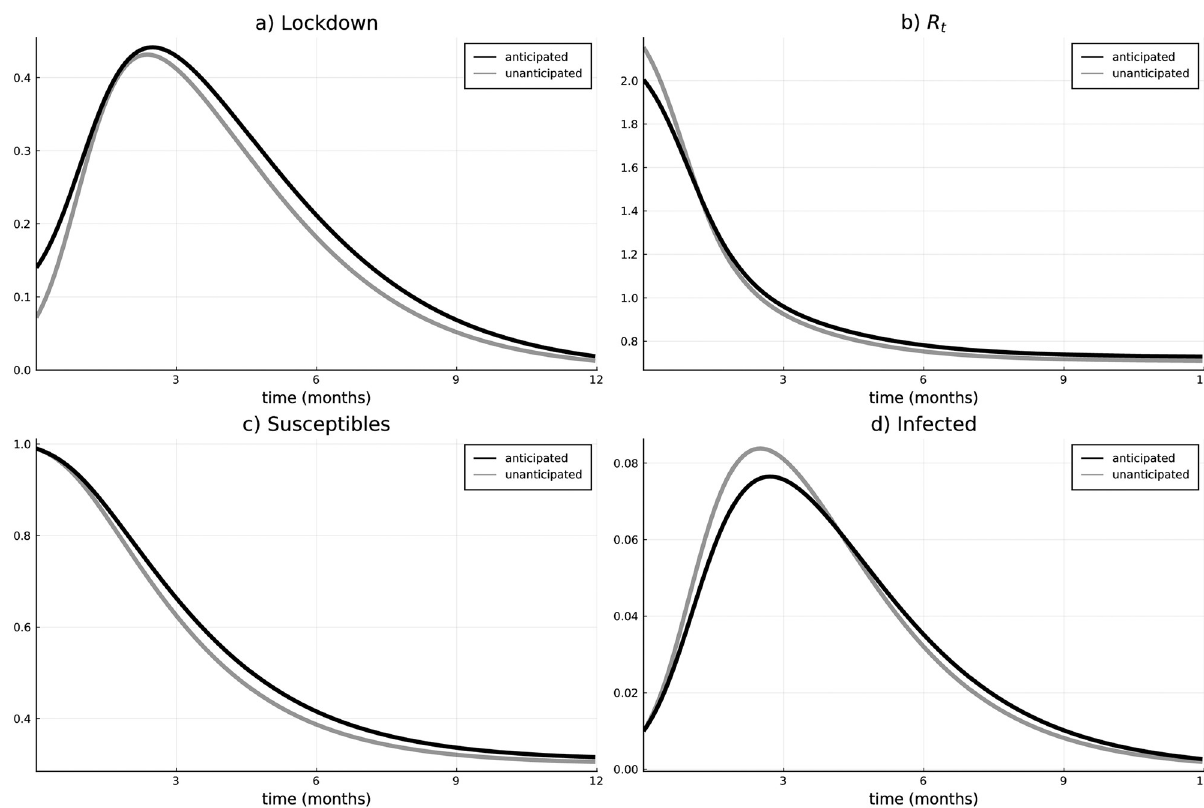
Fig 7. Anticipation versus non-anticipation. (a) Lockdown intensity in the anticipated and non-anticipated case, (b) Effective reproduction number in the anticipated and non-anticipated case, (c) Susceptibles, (d) Infected.